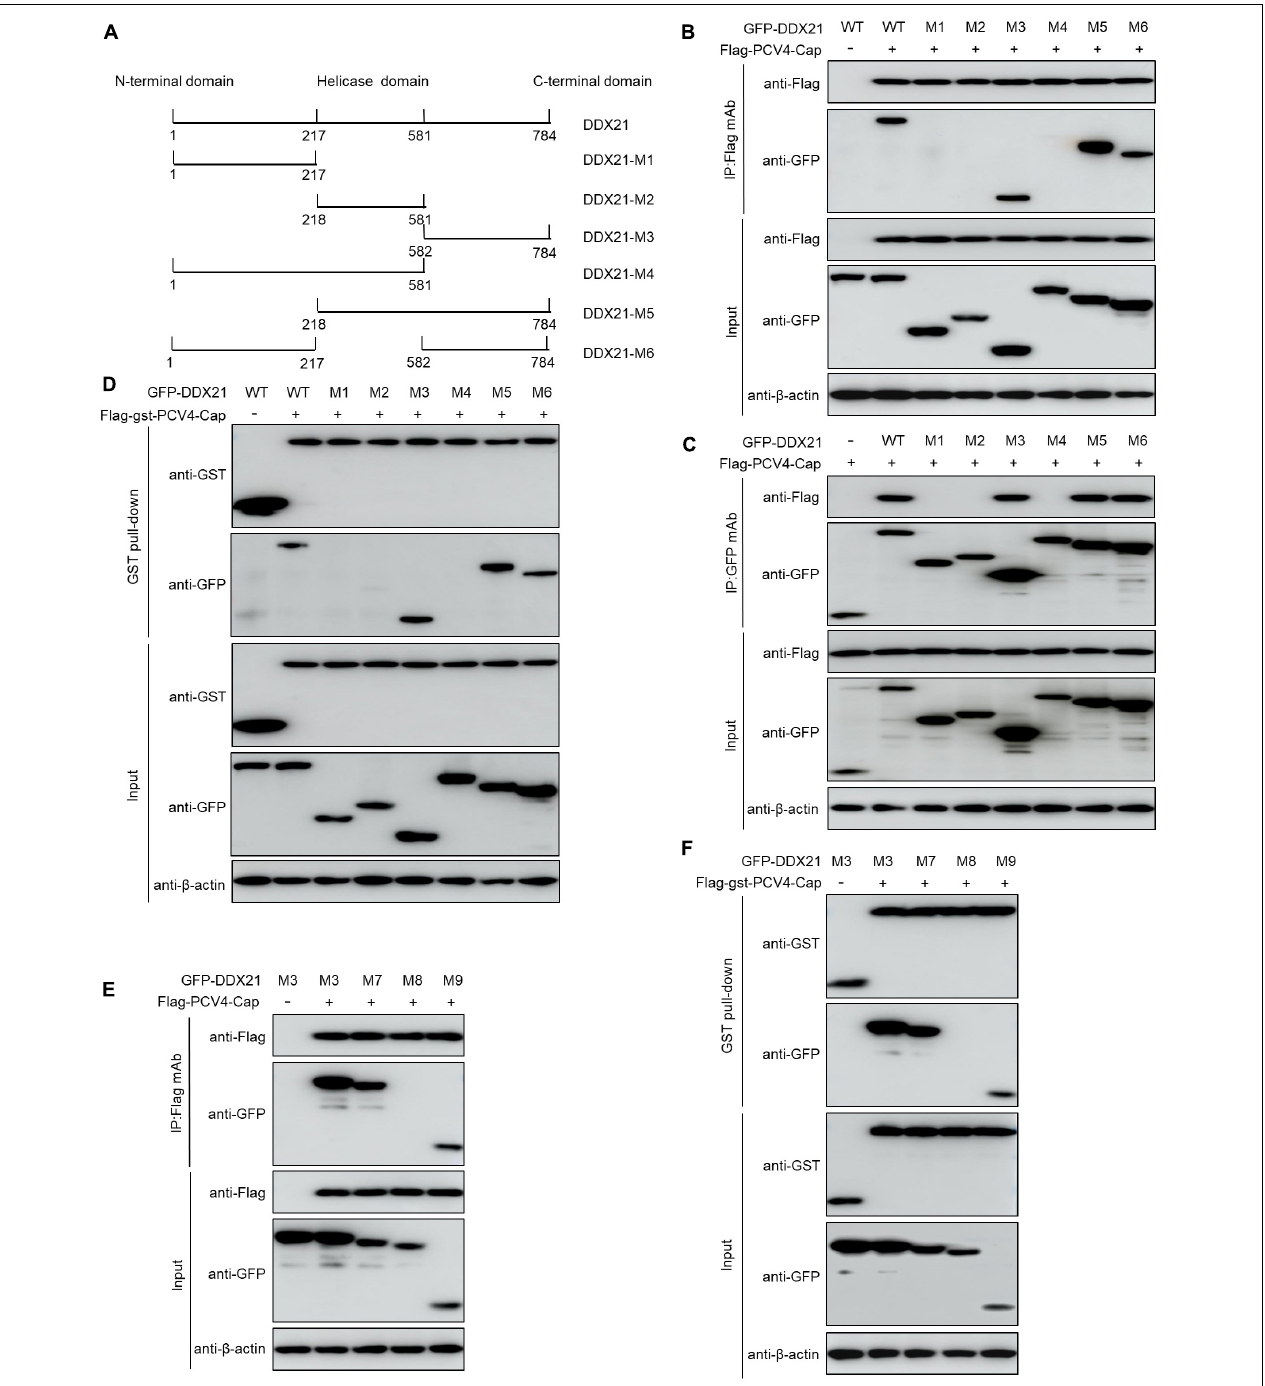
FIGURE 4 | 763 GSRSNRFQNK 772 of DDX21 is crucial for binding to PCV4 Cap. (A) Schematic representation of the NTD, Helicase D, and CTD of DDX21 and their truncation mutants used in this study. (B–D) The DDX21-CTD-(582–784 aa) interacted with PCV4 Cap. HEK293T cells were co-transfected with expression plasmids GFP- DDX21-WT or its serial GFP-DDX21 truncated mutants M1 to M6, together with Flag-PCV4-Cap or Flag-gst-PCV4-Cap plasmid. The cell lysate extracts were immunoprecipitated or GST pulled-down followed by western blotting using the indicated antibodies. (E,F) Identification the critical amino acids of DDX21-CTD essential for interaction with PCV4 Cap. HEK293T cells were co-transfected with DDX21 or DDX21 truncated mutants M7 to M9, along with Flag-PCV4-Cap or Flag-gst-PCV4-Cap plasmid, and the cell lysate extracts were immunoprecipitated or GST pulled-down followed by western blotting using the indicated antibodies.